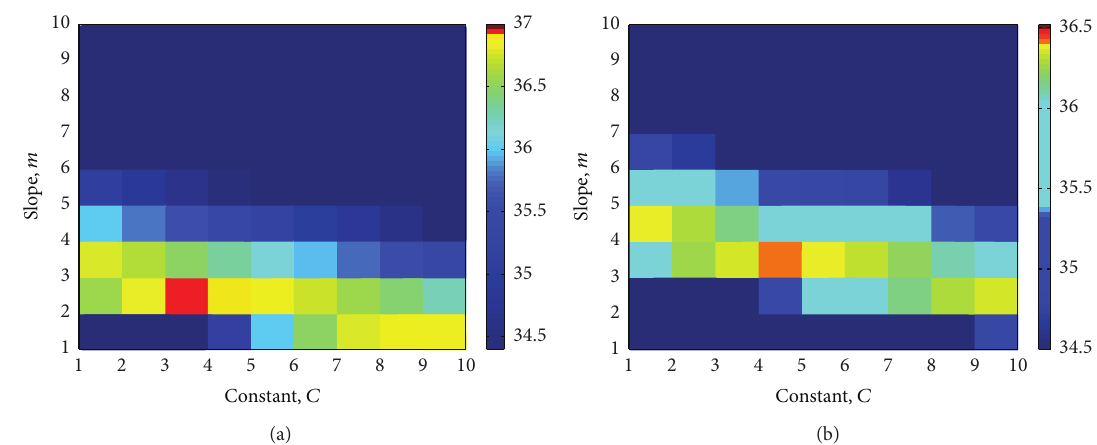
Figure6:Efficiencyasafunctionofslope 𝑚 andconstant 𝐶 underaGaussianirradiancedistribution(PAR=5.3)at(a)1000and(b)2500suns. The color bar indicates the efficiency values (%) obtained with each